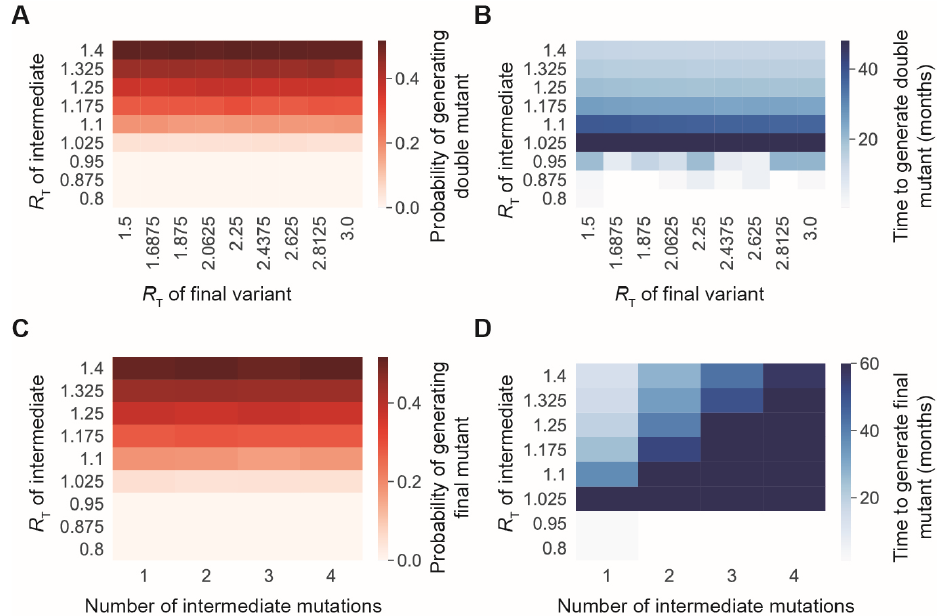
Figure 1. The transmission rate of intermediate SARS-CoV-2 mutants impacts the rate at which more transmissible variants with multiple mutations appear. ( A ) Probabilities of generating a double- mutant lineage that establishes in the population before the extinction of the single mutant, for different R T values of the single mutant ( y -axis) and the double mutant ( x -axis) R T . ( B ) Time to generate a double mutant variant after the initial mutation occurs in one host, given that a double mutant eventually arises. This was plotted for different R t values of the single mutant ( y -axis) and the double mutant ( x -axis) R T . ( C ) Probability of generating a variant with multiple mutations from a specific single-mutant lineage before its extinction, for different values of the transmissibility of the intermediate variants ( y -axis) and the number of intermediate mutations required before the final variant can be generated ( x -axis). ( D ) Time to generate a multiple-mutant variant after the initial mutation occurs in one host, given that the final variant eventually arises from the original single mutant. This was plotted for different values of the transmissibility of the intermediate variants ( y -axis) and the number of intermediate mutations required before the final variant can be generated ( x -axis). For all panels, n = 10,000 simulation was